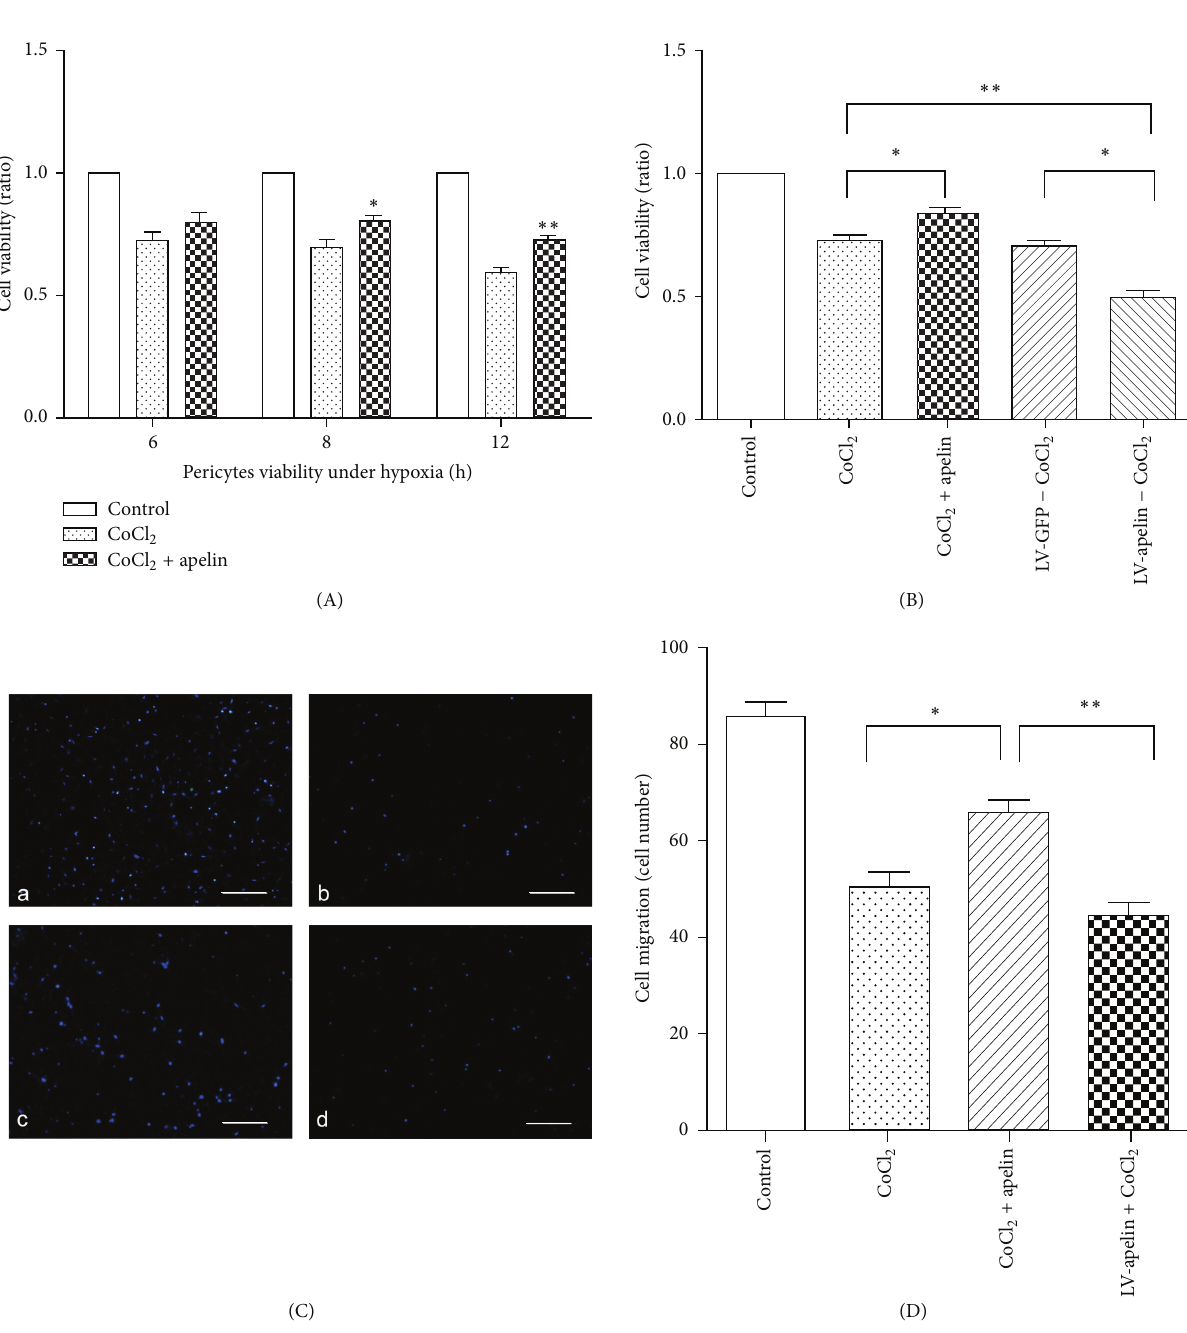
Figure 6: Effect of apelin on cell viability and migration under hypoxia. Cell viability was evaluated by MTS assay and migration was assessed with a transwell cell chamber. (A) In hypoxic pericytes, the viability of cells stimulated by apelin was significantly enhanced during 12 h (8h versus CoCl 2 ∗ 𝑃 < 0.05 ; 12 h versus CoCl 2 ∗∗ 𝑃 < 0.01 ). (B) Viability of pericytes treated with apelin and LV-apelin knockout under hypoxia. Compared with the CoCl 2 group, viability was significantly increased in the apelin group ( P < 0.05). Moreover, cell viability was significantly reduced in the LV-apelin knockout group (LV-GFP versus LV-apelin, P < 0.05; CoCl 2 versus LV-apelin, P < 0.05). (C) and (D) Pericyte migration induced by apelin under hypoxia (a: control; b: CoCl 2 150 𝜇 mol; and c: CoCl 2 150 𝜇 mol + apelin 100ng/mL). The number of migrated cells per HPF is shown. Apelin versus CoCl 2∗ 𝑃 < 0.05 . Scale bar = 200 𝜇